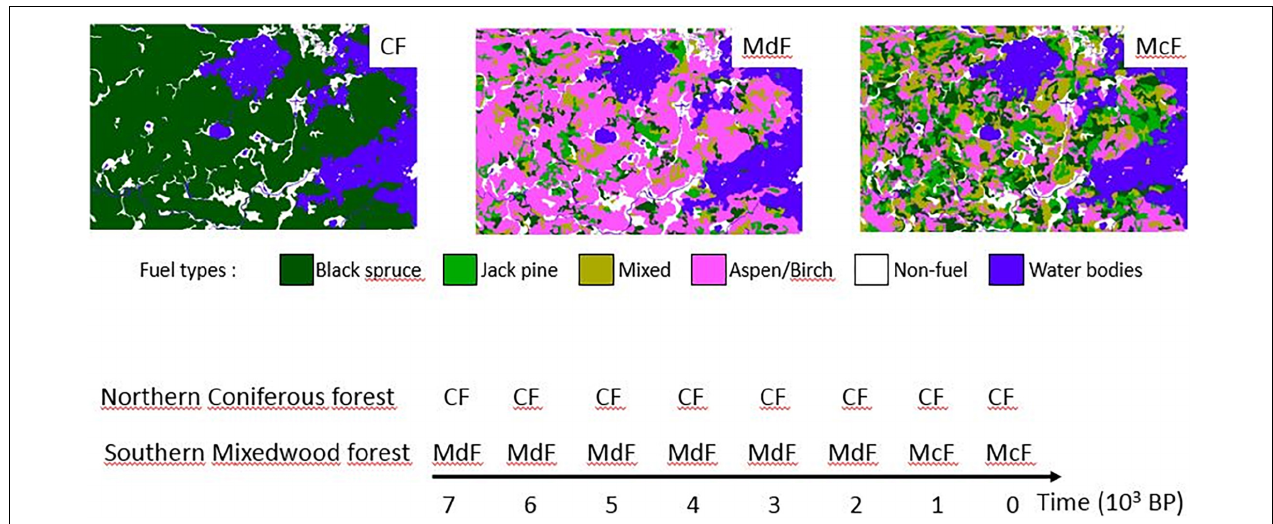
FIGURE 2 | Forest composition scenarios used to run the PFAS fire model (top) and schematic vegetation changes over time (bottom) . The boreal coniferous forest (CF) landscape is representative of the northern black spruce forest, with a stable composition since the end of the last deglaciation. The boreal mixedwood forest landscape, dominated by broadleaf deciduous species (MdF), either as pure deciduous stands or as mixed stands in which deciduous species dominate (i.e., a total deciduous percentage of 70%), is representative of the southern part of the study region during most of the Holocene (i.e., 8,000–2,000 years BP). The boreal mixed forest landscape, dominated by coniferous species (McF), either as pure coniferous stands or as mixed stands in which the coniferous species dominated (70%), is representative of the late Holocene (1,500–0 years BP), when it replaced MdF. Such a compositional shift (from MdF to McF) arose from the Neoglacial period that started around 3,000 years BP, reflecting the vegetation response to cooler and moister conditions than those prevailing earlier in the Holocene. Local and regional pollen analyses (Carcaillet et al., 2001; Blarquez et al., 2015a) show that this was a two-step response, with a decrease in deciduous species abundance that in turn provided space for coniferous abundance to increase. Both MdF and McF represent the boreal mixed forest (MF) for comparison with